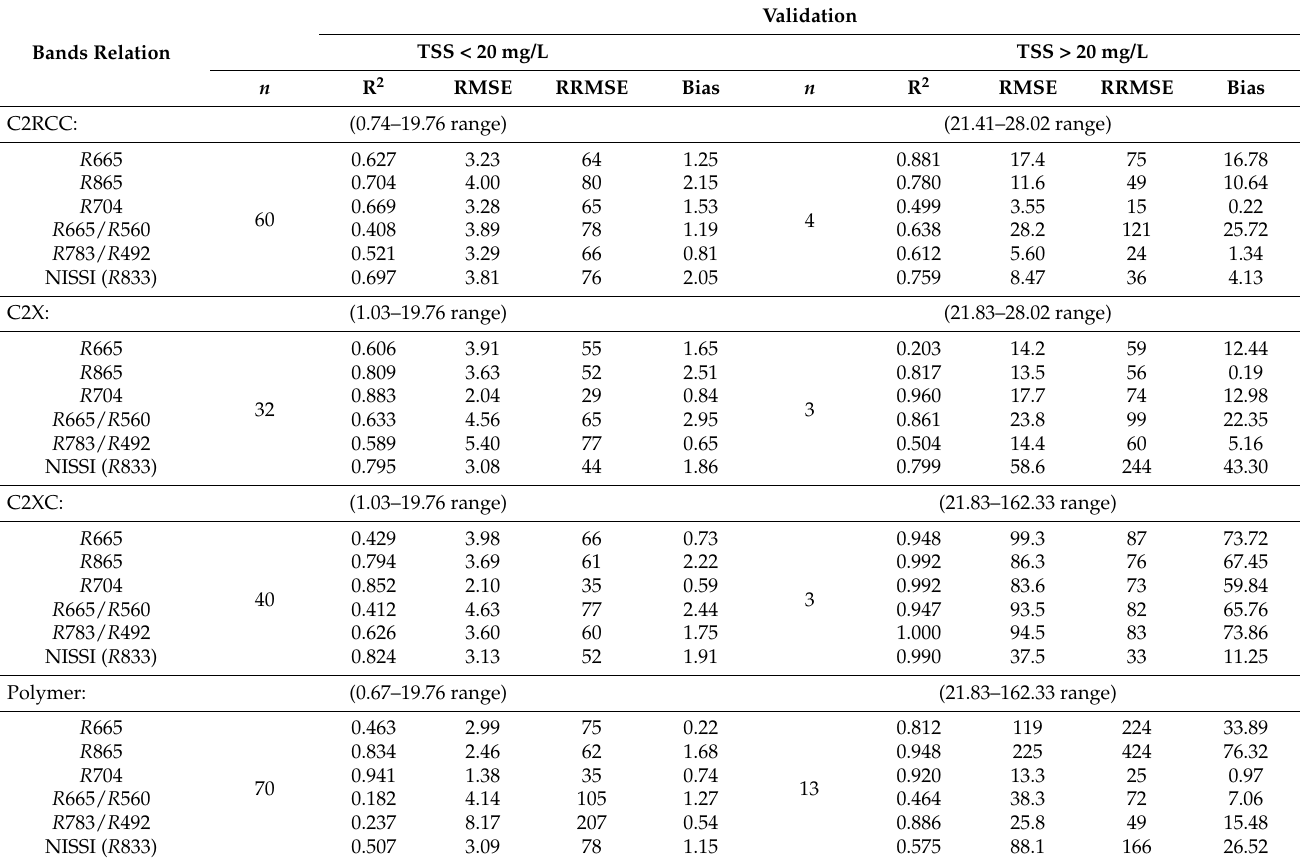
Table A4. TSS validation results for in situ spectrometry waters quality algorithms and AC type.